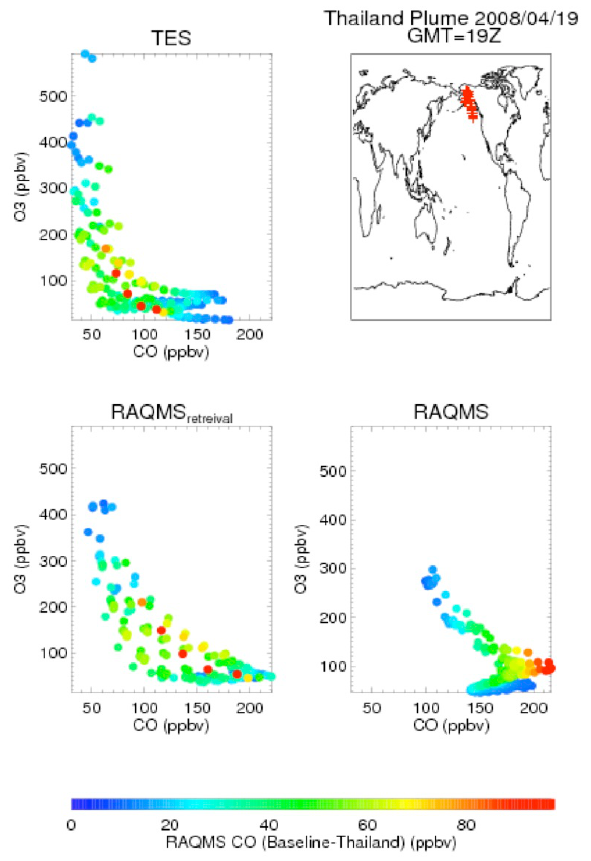
Fig. 11c. Same as Fig. 11a but near DC9 in situ measurements.